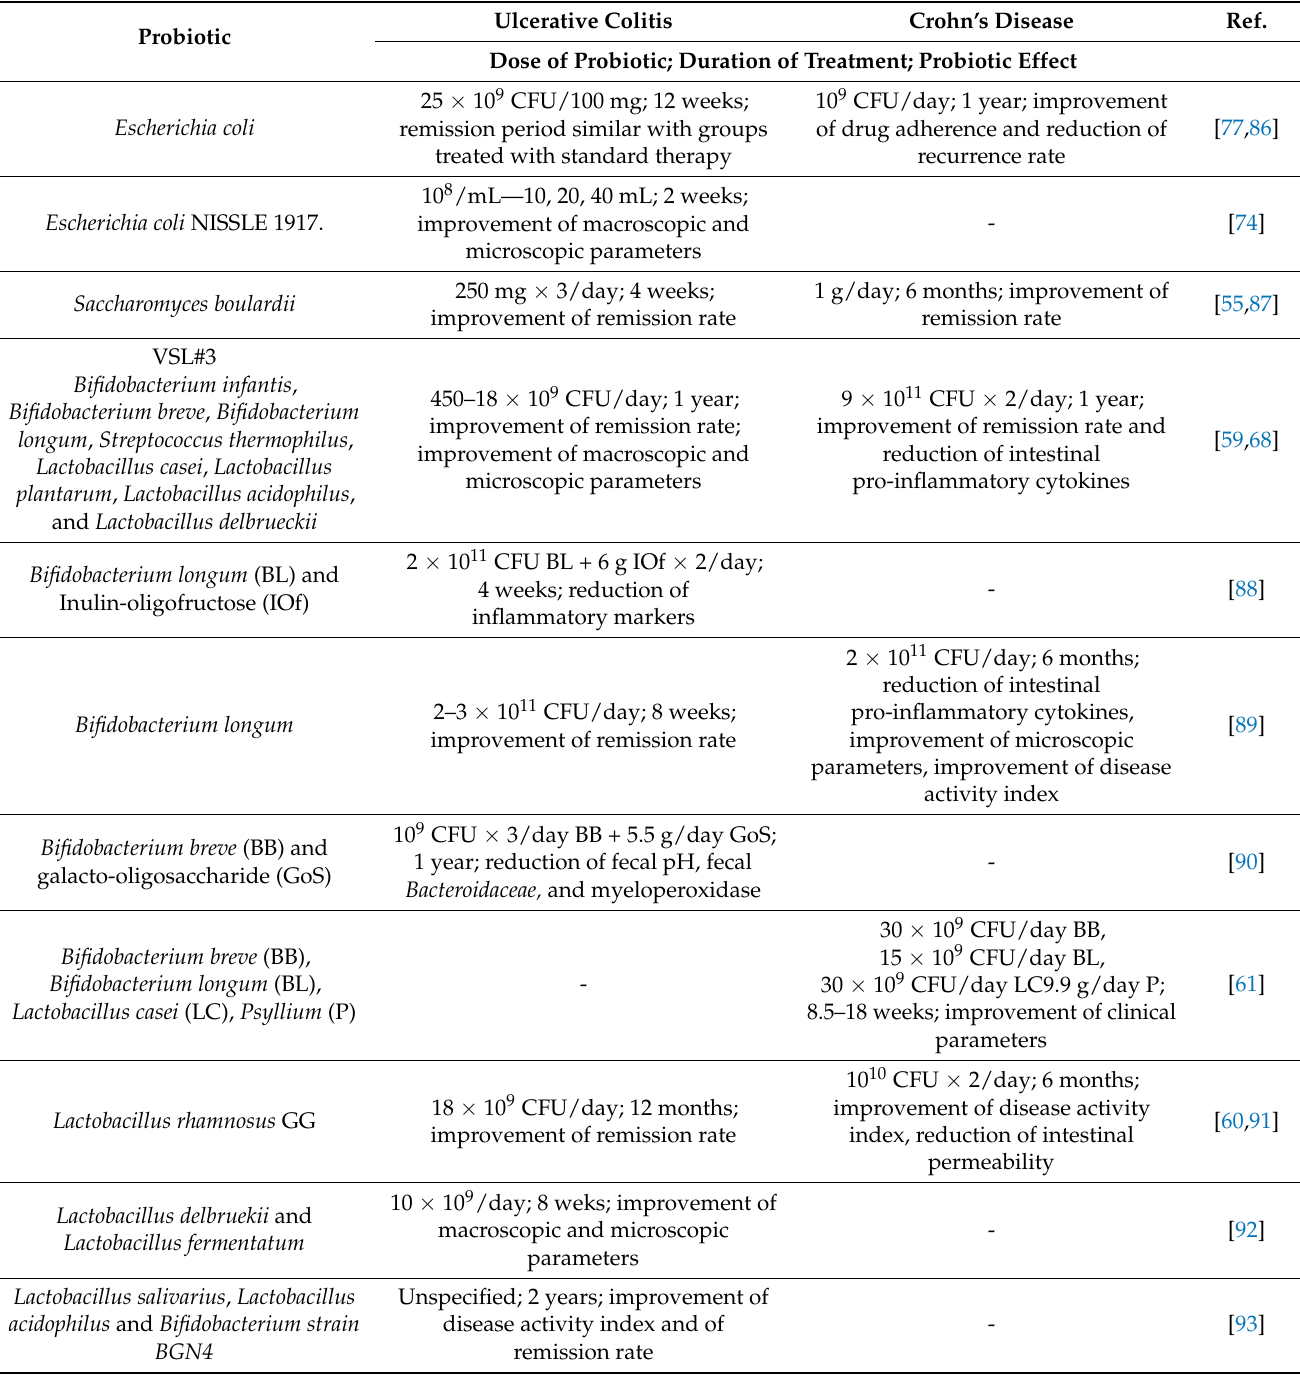
Table 1. Dose, duration of treatment, and efficiency of probiotic in ulcerative colitis and Crohn’s